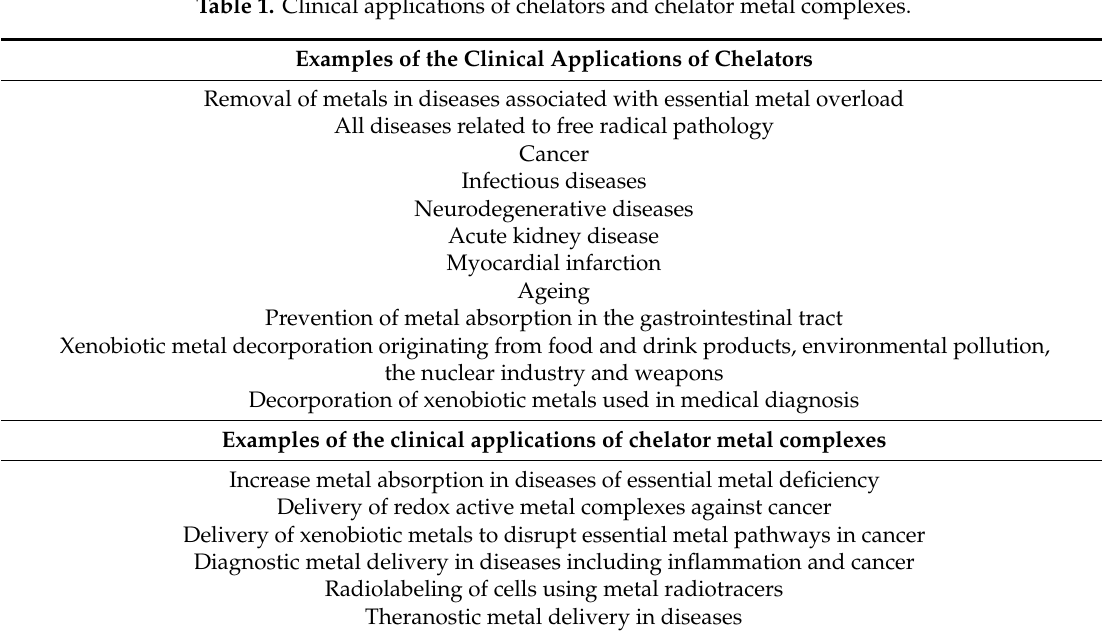
Table 1. Clinical applications of chelators and chelator metal